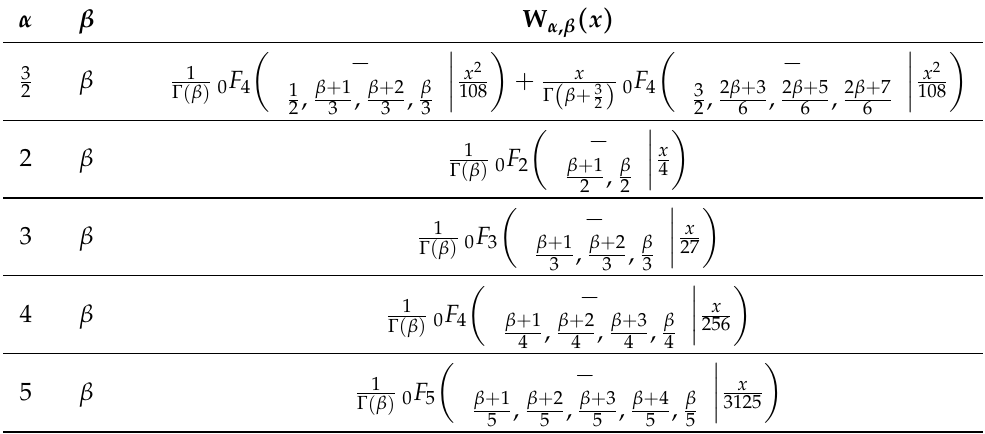
Table A14. The Wright functions W α , β derived for some values of parameters α and β by using (39).